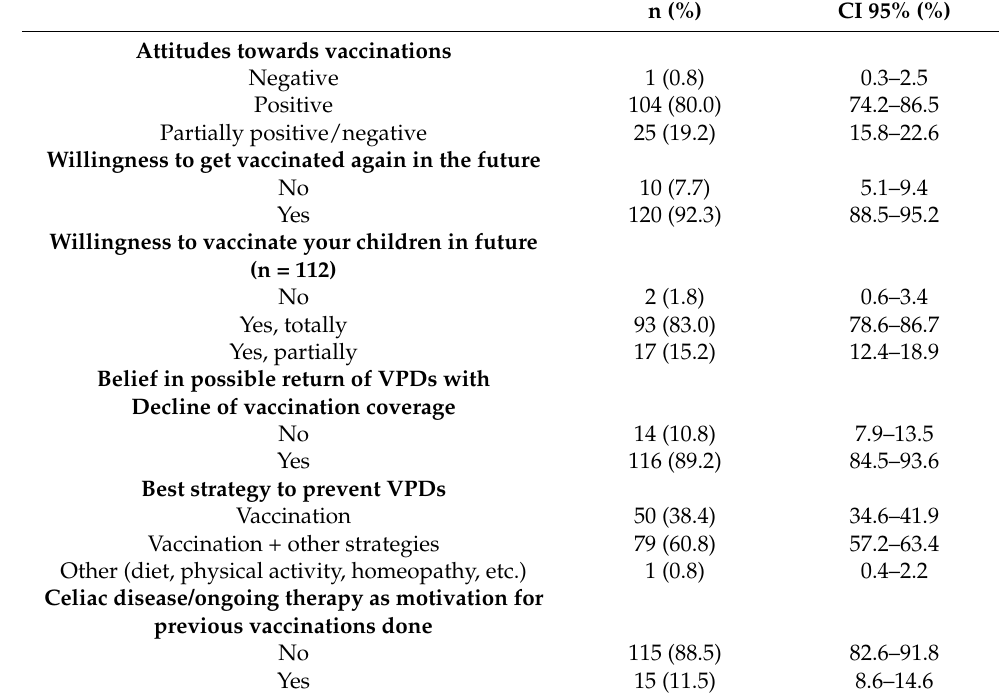
Table 4. Attitudes towards vaccinations in the study population (n =